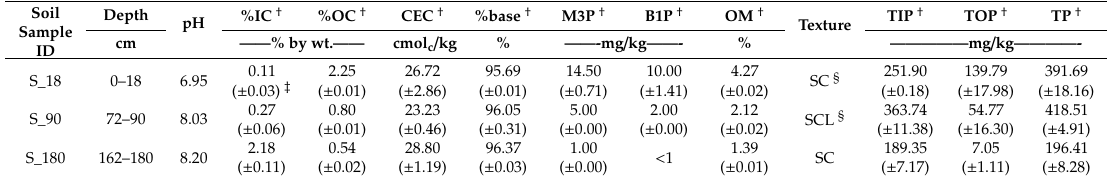
Table 1. Selected physicochemical properties and P concentrations of Douglas County soils.